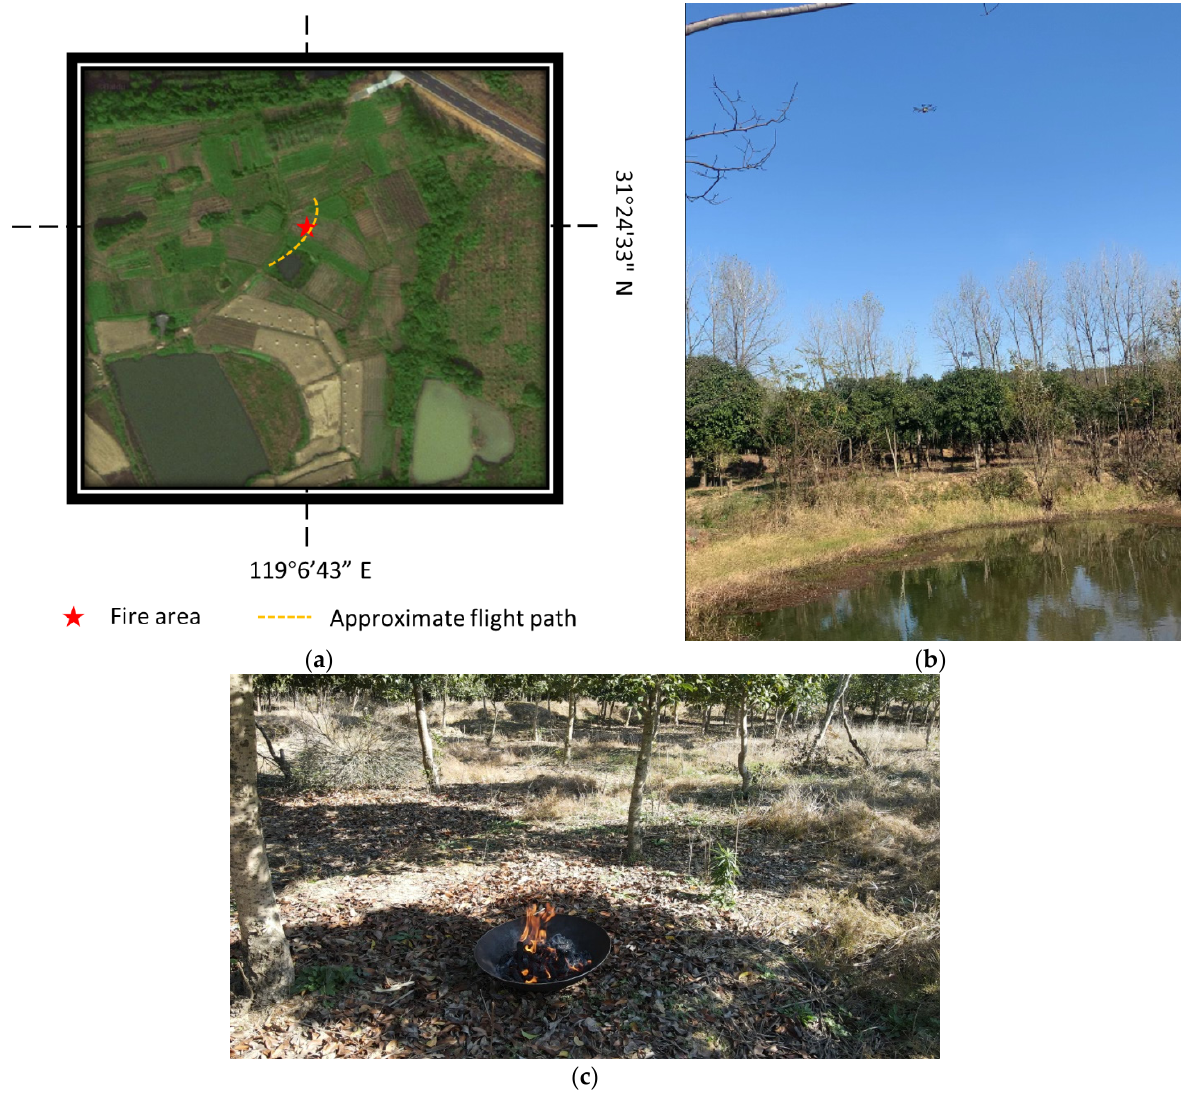
Figure 13. The demonstration of the experimental environment. ( a ) Real-world test scenarios at (119°6 ′ 43.26 ″ E, 31°24 ′ 33.92 ″ N) and the approximate flight path; ( b ) side view of the testing environment; and ( c ) the fire simulator, with an iron pot and some combustibles.